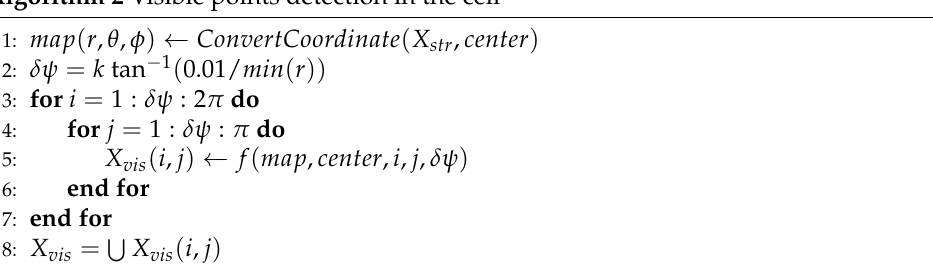
Algorithm 2 Visible points detection in the